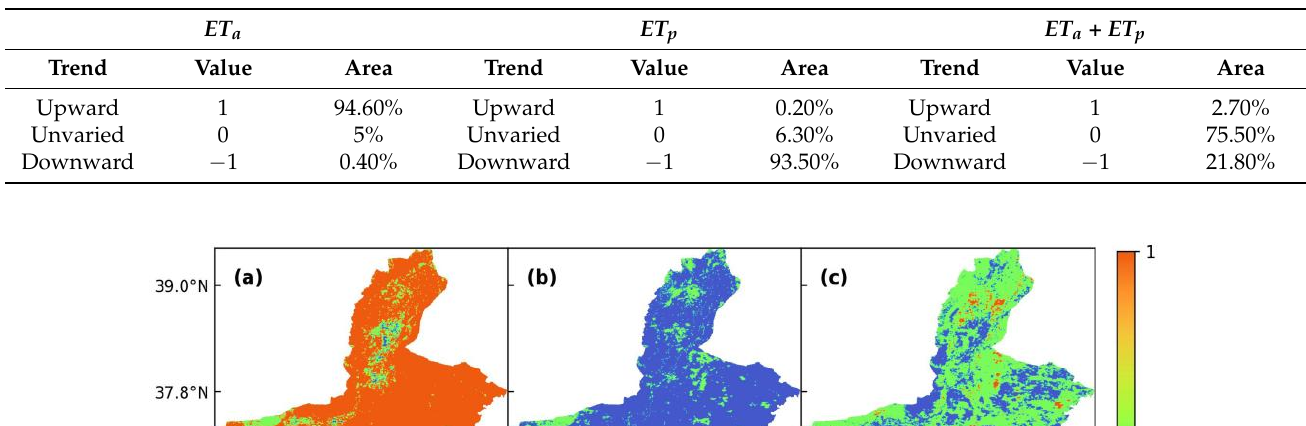
Table 6. Observations of BPI pan ( ET s ), MODIS AET ( ET a ) and MODIS PET ( ET p ) over the past 20 years at six meteorological stations in Ningxia (mm).